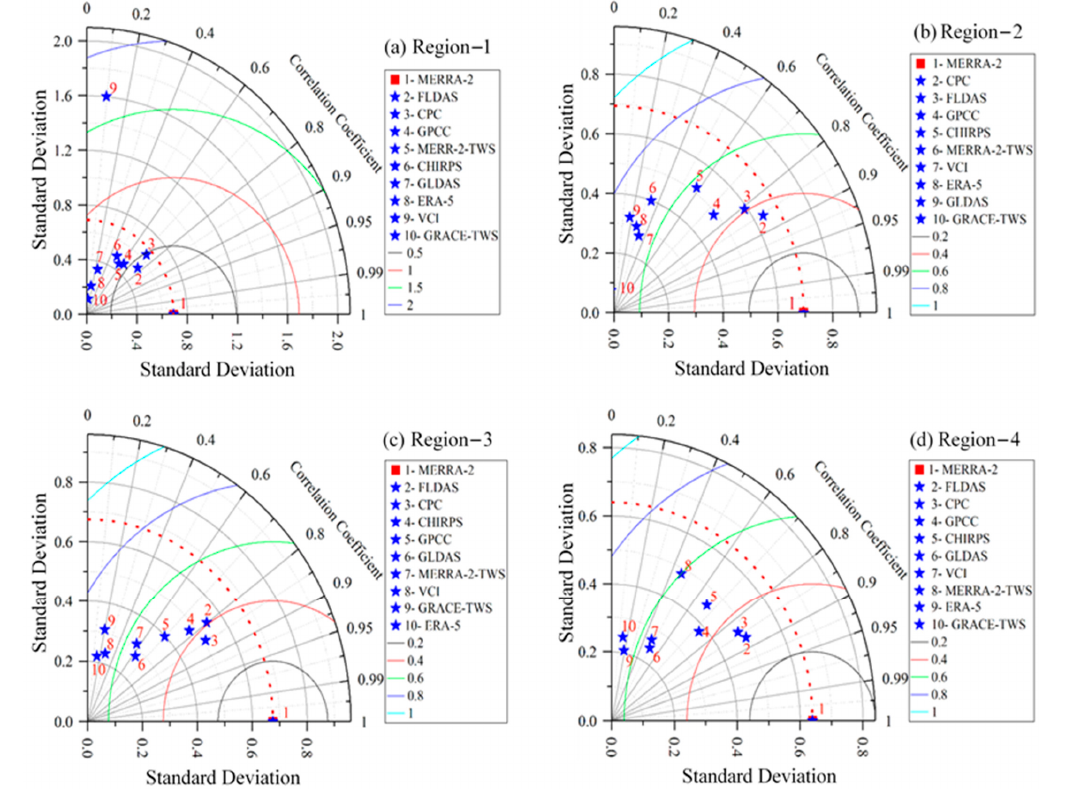
Figure 7. ( a – d ) Taylor diagrams indicating the overall rankings of products (SSMI from MERRA-2, FLDAS, CPC, GLDAS and ERA5, SPI from CHIRPS and GPCC, TWSI from MERRA-2, SA from GRACE, and VCI from AVHRR) relative to MERRA-2 soil moisture over all regions of South Asia. The angular axis denotes the coefficient of correlation and the radial axis indicates the standard deviation. The semi-circle demonstrates the root mean square difference (RMSD).